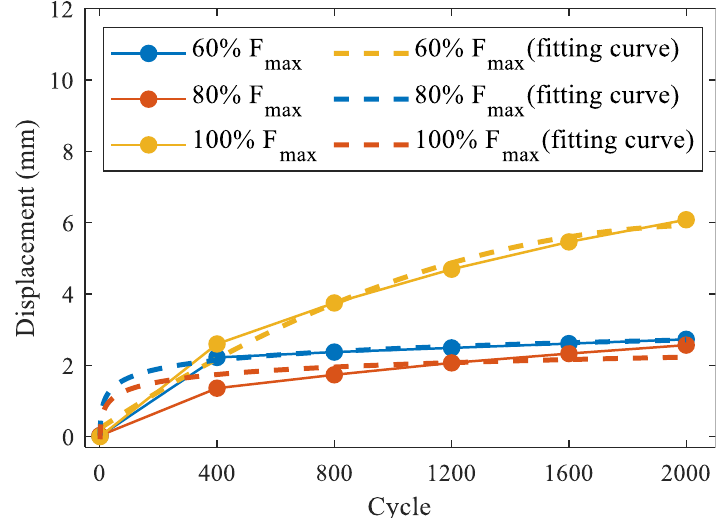
Figure 14. Cycle times –cumulative displacement relationship for variable loading amplitudes (θ = 45°).